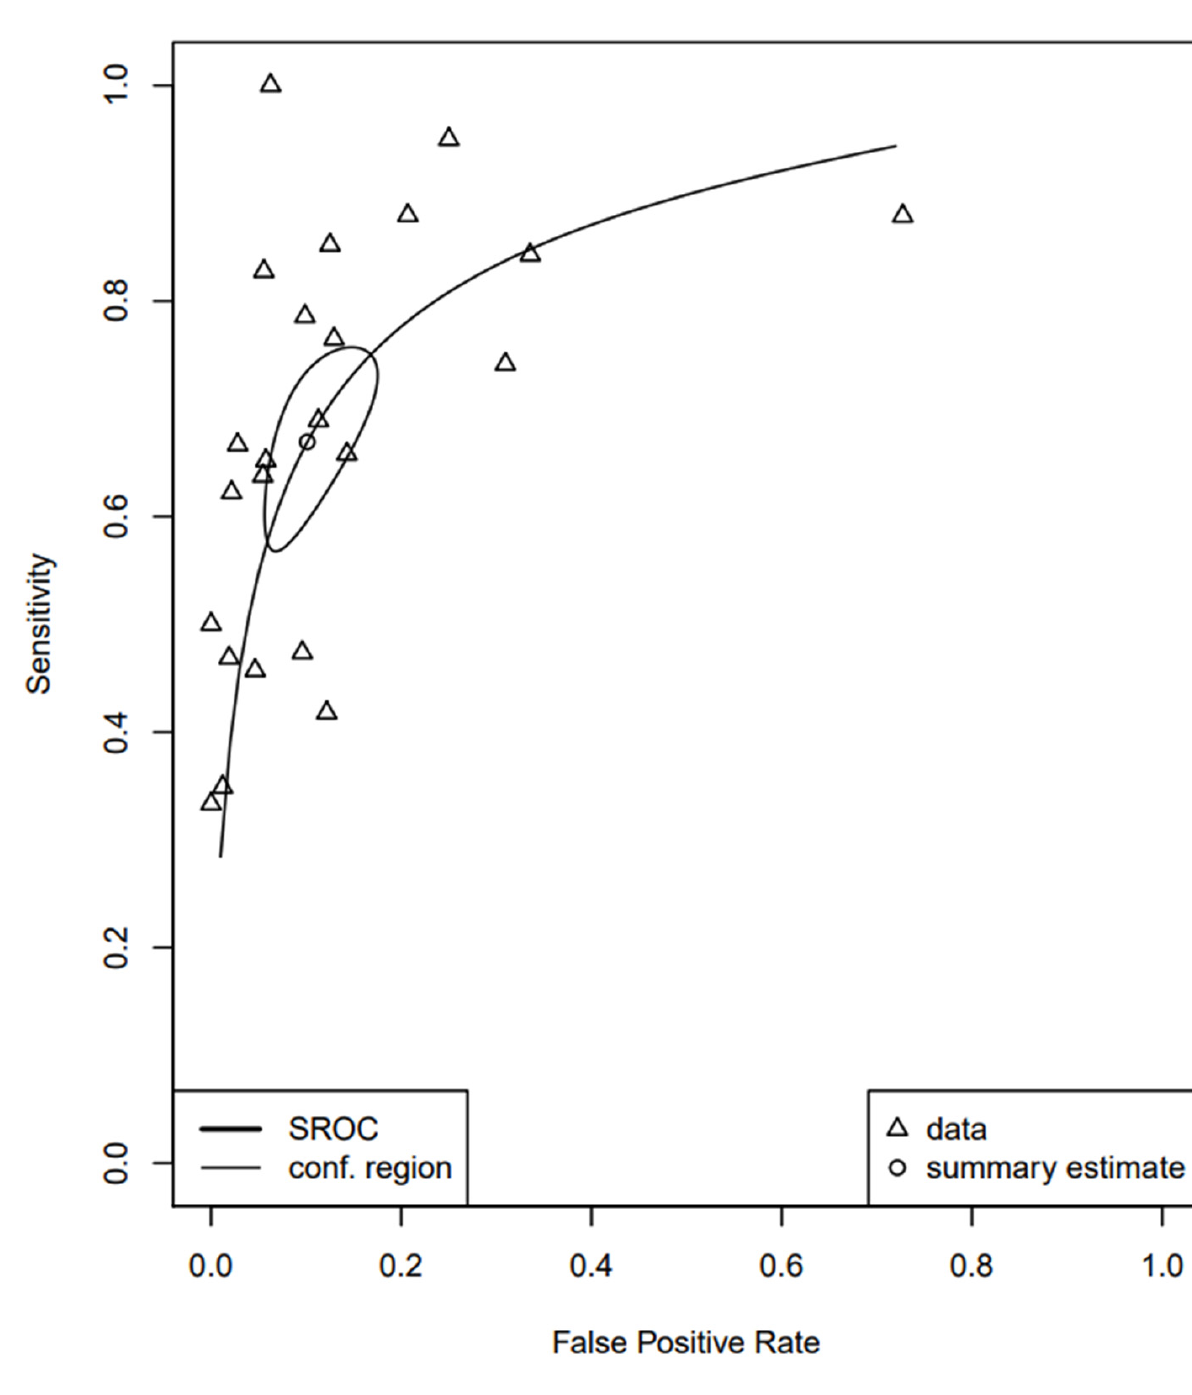
Figure 2. SROC curve of the included studies.